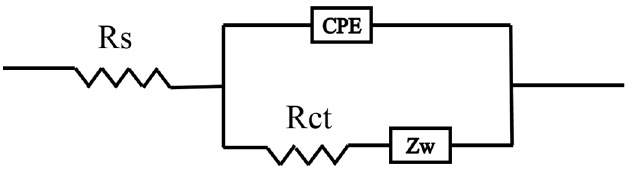
Figure 10. Equivalent circuit model. Table 3. Rs ( Ω ) and Rct ( Ω ) of the PANI/nano-NiO in different concentration of KI. Sample